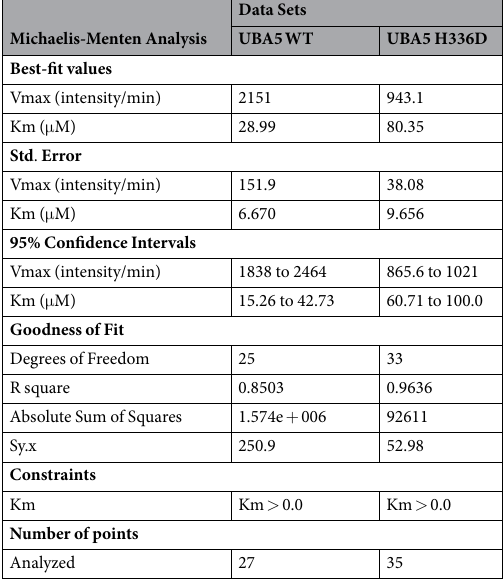
Table 3. Constants and statistics from fits of UBA5 steady-state saturation kinetics to the Michaelis-Menten